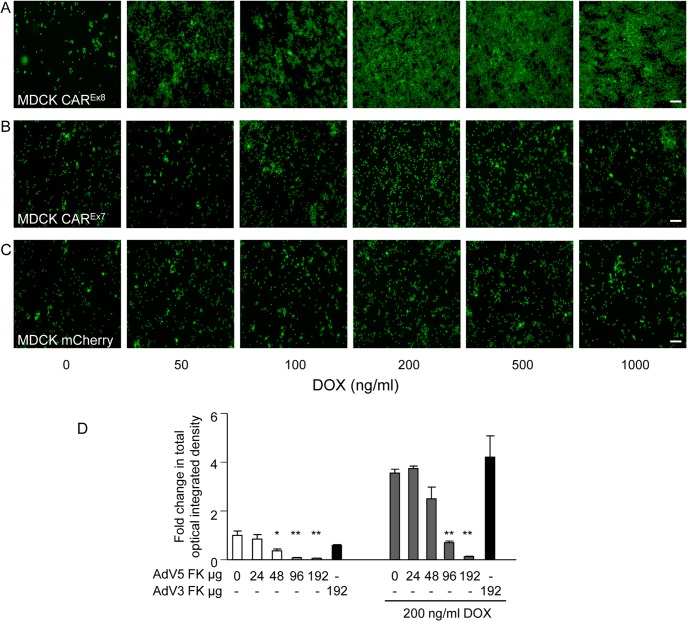
Apical CAREx8 protein expression increases apical neutrophil adhesion that is sensitive to AdV5 FK.A neutrophil adhesion assay was performed on mock (0) or DOX-induced A) MDCK-CAREx8, B)-CAREx7, or C)-mCherry cells. Adhered neutrophils (green) on the surface of the epithelial cells were captured by fluorescence microscopy (10X; white bar = 100 μm). D) MDCK-CAREx8 either mock (0) or DOX-induced, as indicated, were treated with AdV5 FK or AdV3 FK immediately prior to performing the neutrophil adhesion assay. Adhered neutrophils were captured by using fluorescence microscopy and quantitated using Metamorph software. Images and quantitation are representative of 5–10 images from at least 3 separate experiments. Error bars represent the SEM from three independent experiments; *p < 0.05 or **p < 0.01 by one-way ANOVA. White bar, 100 μM.